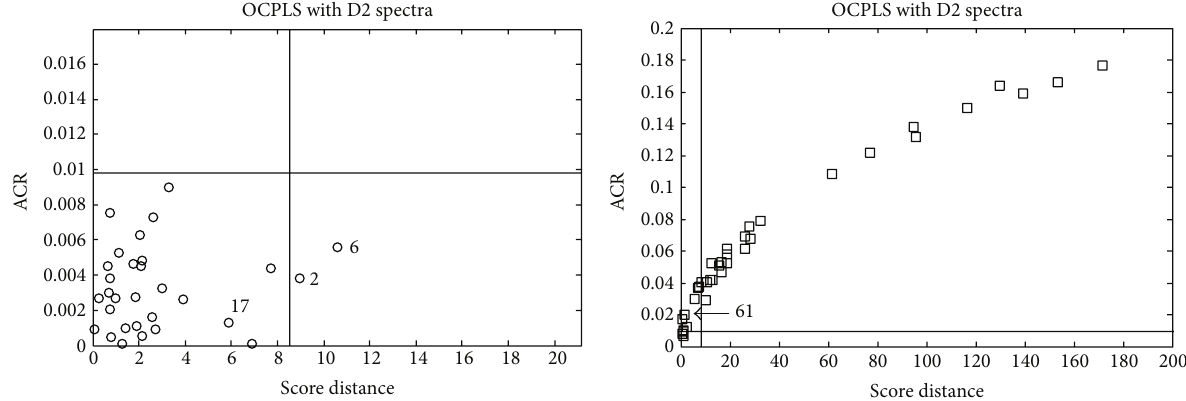
specificity of OCPLS for identifying non-PDO objects,